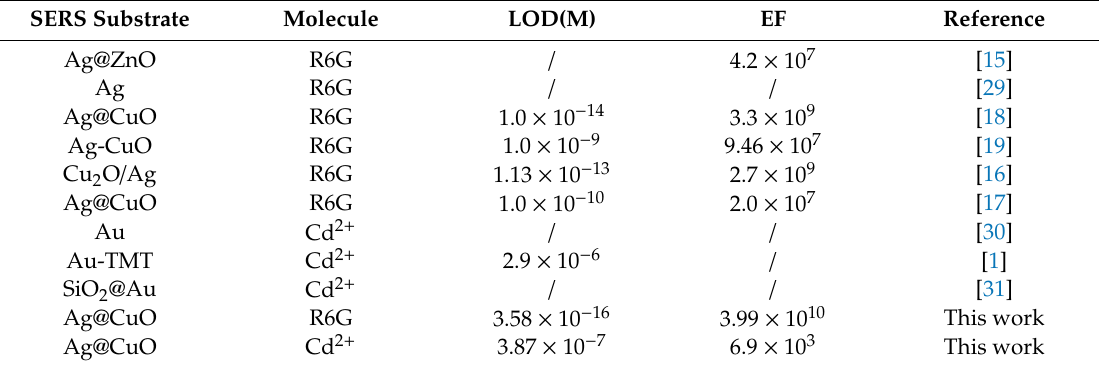
Table 1. Comparison of SERS EFs of our substrates and other substrates. SERS Substrate